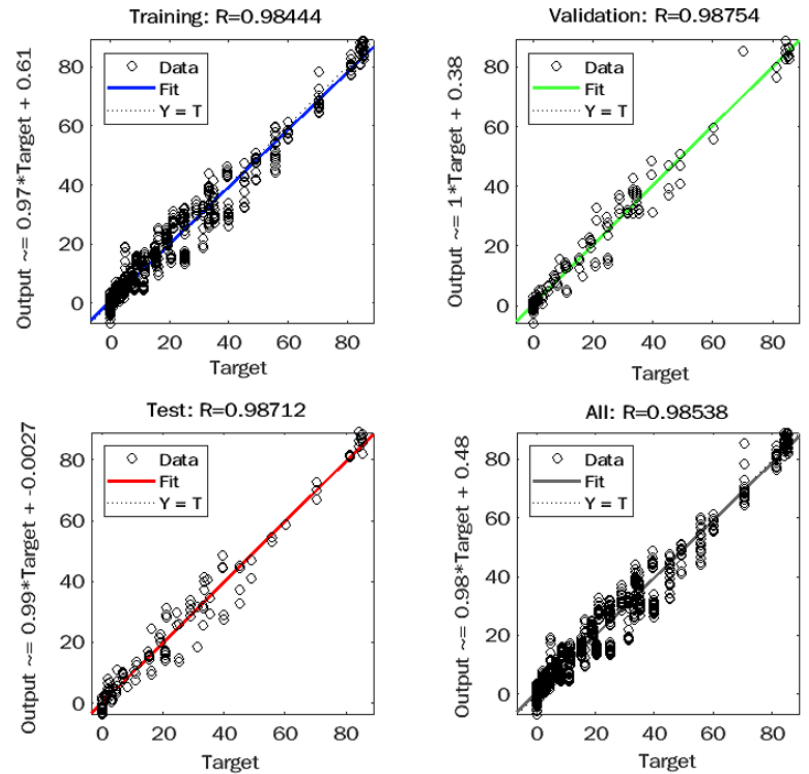
Figure 12. Observed versus predicted plot for R 3.2 of unaged binders.